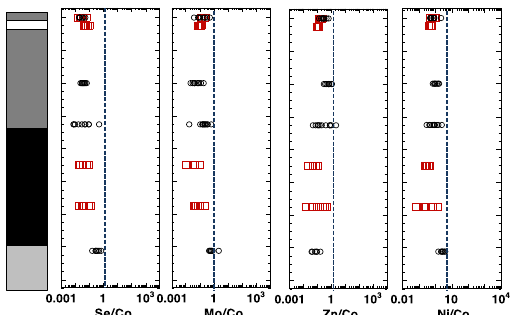
Figure 11. Trace element ratios (Se / Co, Mo / Co, Ni / Co, Zn / Co) in the Bijaigarh Shale Member; dashed line represents Proterozoic mean values [19]; red squares—pyrite lag; black circles—fine-grained pyrite. Other oxygenation proxies such as Se / Co, Mo / Co, and Zn / Co are all below the Proterozoic mean